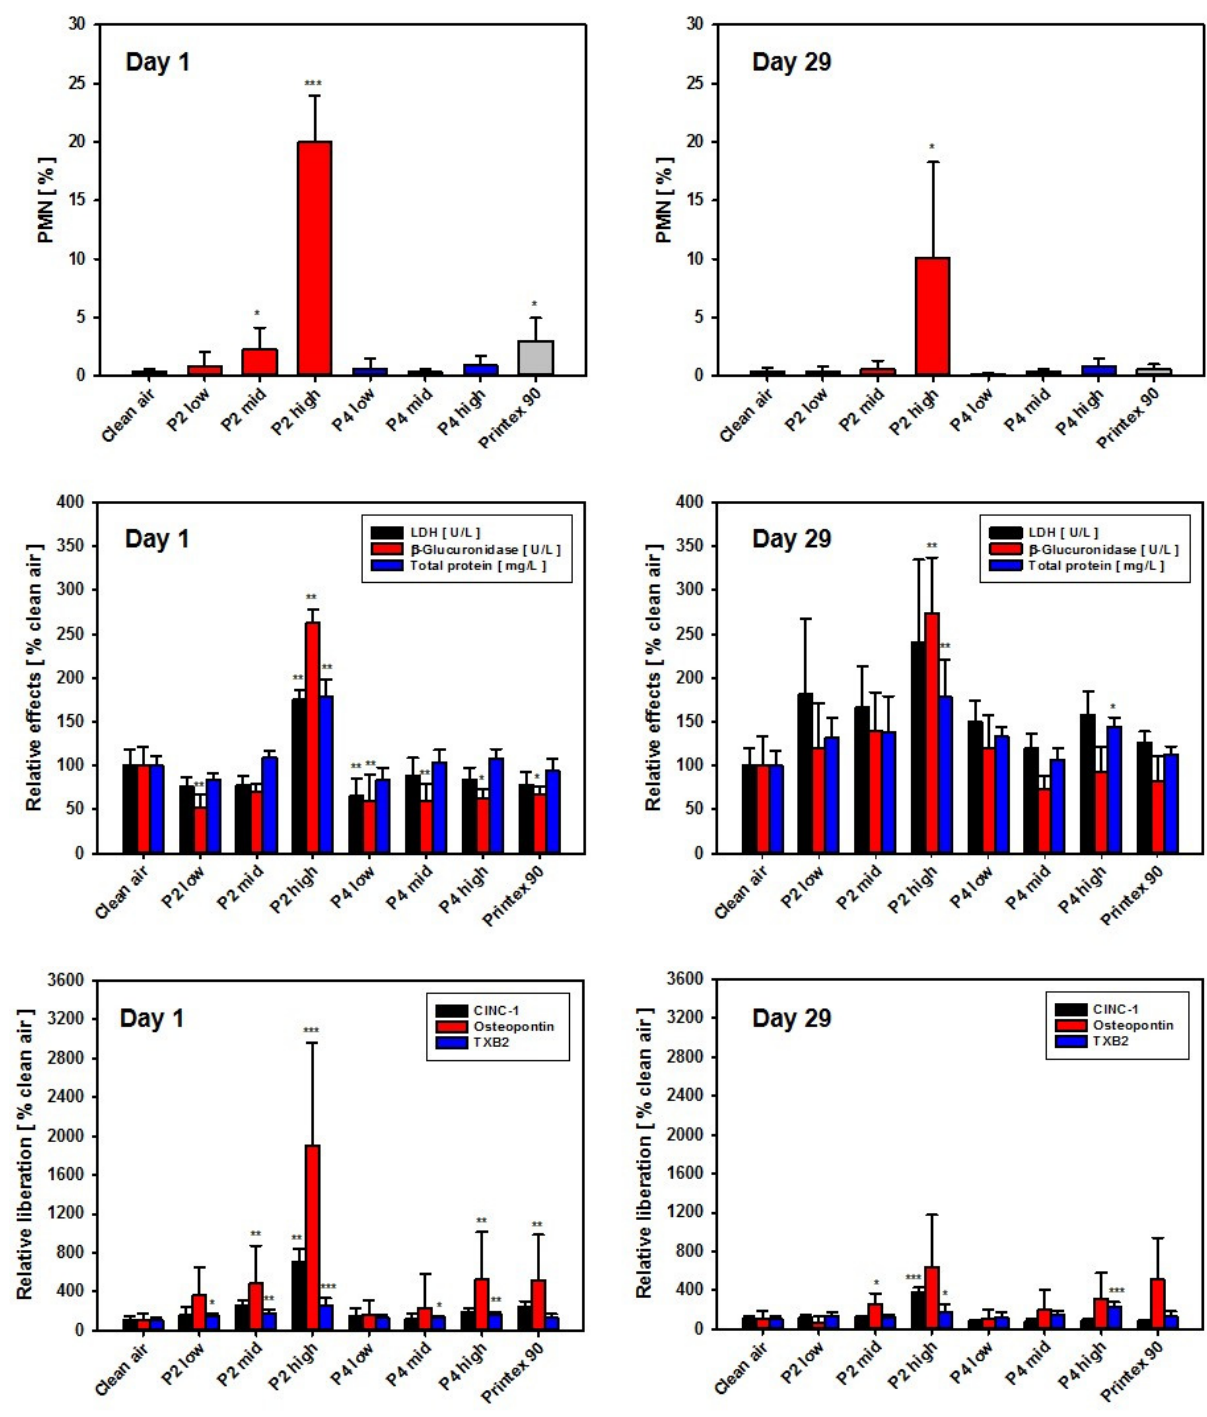
Figure 8. Results of BALF analysis at day 1 (left) and day 29 (right; 28 days of recovery) post-exposure. Depicted from differential cell counts are relative PMN numbers only. Top: PMN [% of total leukocytes]; middle: LDH activity, β -Glu activity, and total protein in BAL [relative to clean air controls set to 100%]; bottom: CINC-1, osteopontin and TXB 2 concentrations in BAL [relative to clean air controls set to 100%]. Data represent the means ± SD of five animals per group. */**/*** Statistically significant difference from negative control (clean air): p ≤ 0.05 or p ≤ 0.01 or p ≤ 0.001, respectively; Student’s t -test for unpaired values, two-tailed.